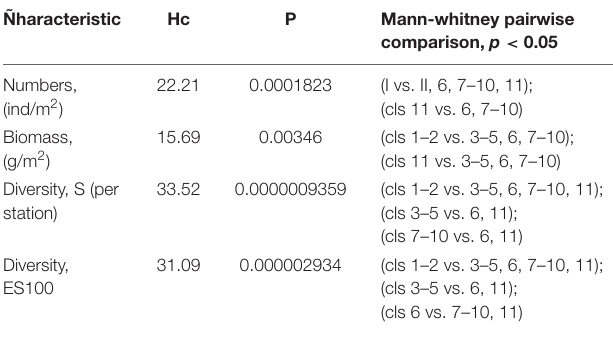
TABLE 3 | Summary table of Kruskal-Wallis test results comparing the integral characteristics between the five identified